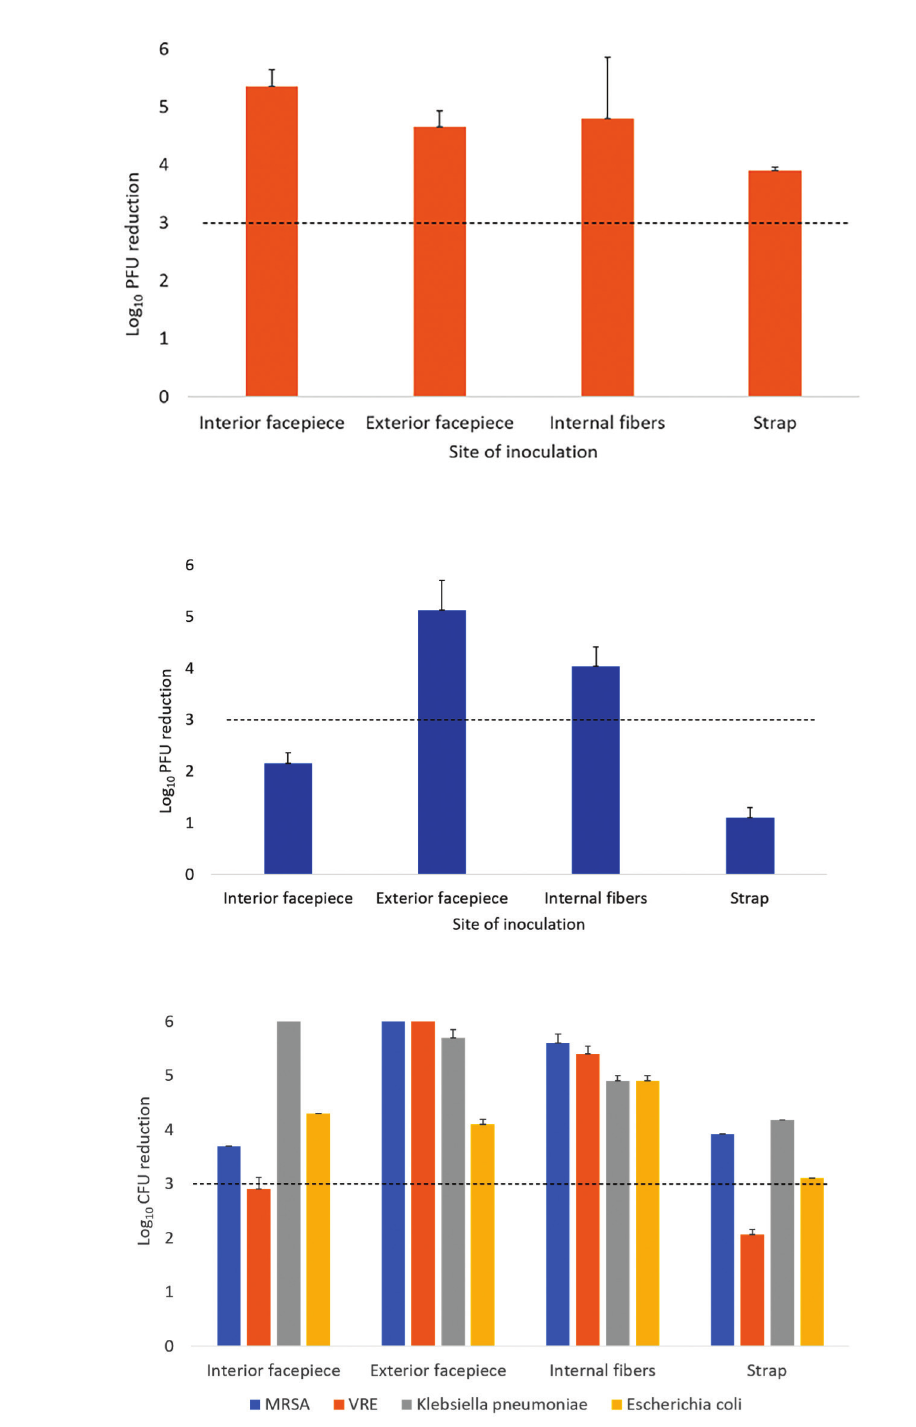
Figure 3. Log reductions in bacteriophage MS2 (A and B) and 4 vegetative bacteria (C) on N95 10 respirators after exposure to ultraviolet-C (UV-C) light inside the ARK UV-C box. The test organisms were inoculated on the exterior facepiece, interior facepiece, and internal fibers of Moldex 1513 (A) or 3M 1860 (B and C) respirators. Error bars indicate standard